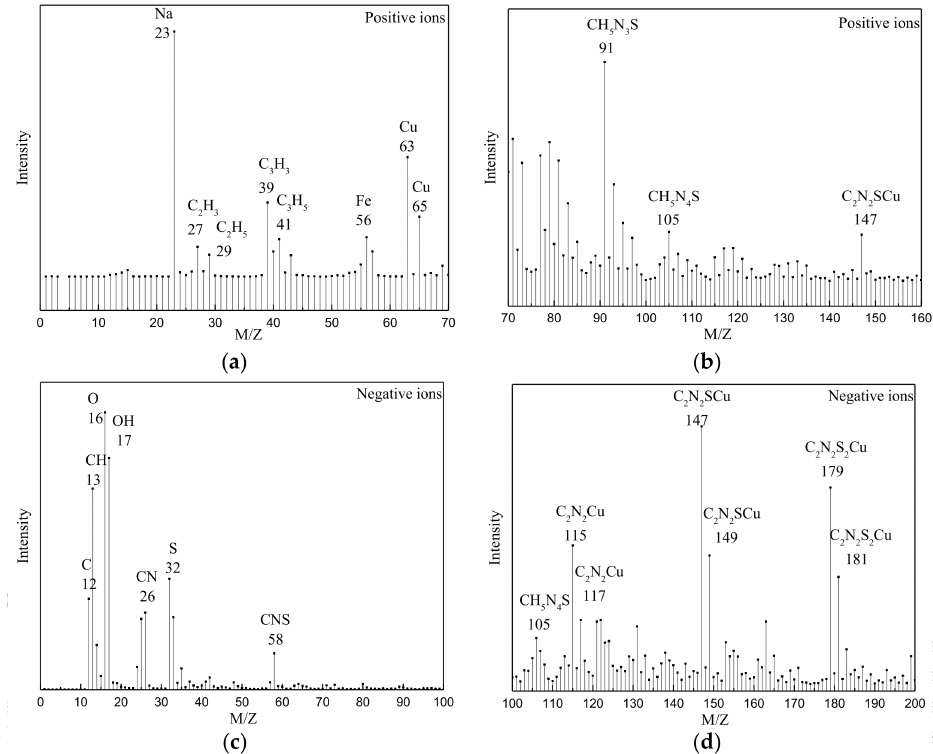
Figure 10. ToF-SIMS spectra of chalcopyrite surface after adsorption of thiocarbonohydrazide, ( a , b ) negative-ions; and ( c , d ) positive-ions